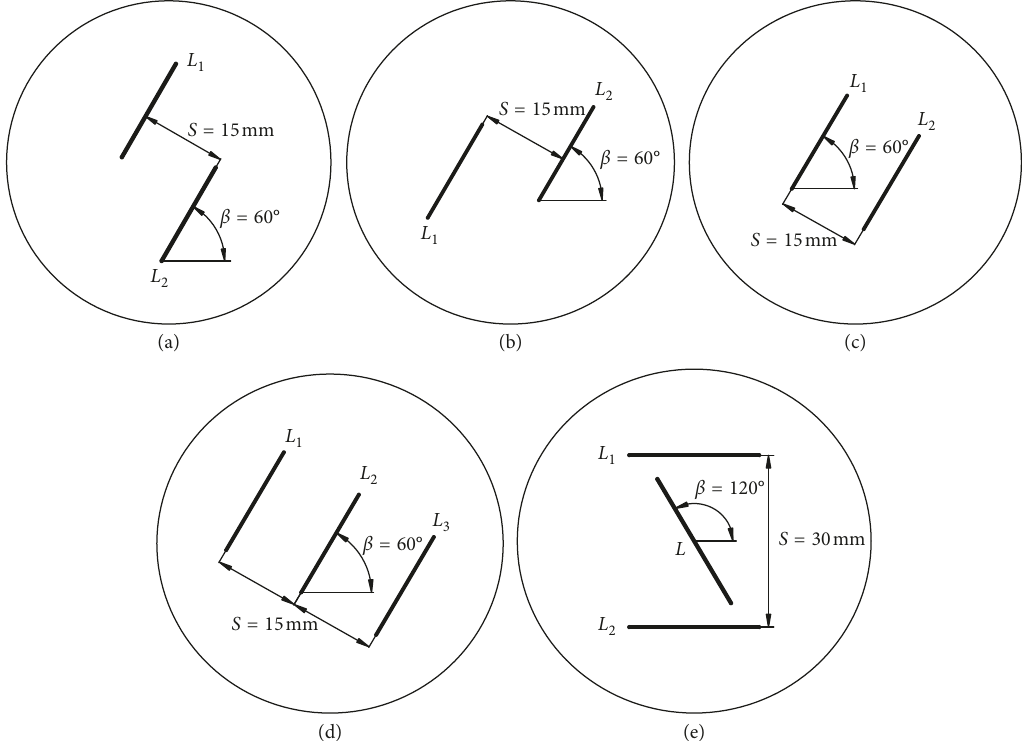
Figure 5: Geometry of pre-cracked specimens with different inclination angles: β � 0, 15 ° , 30 ° , 45 ° , 60 ° , 75 ° , and 90 ° .